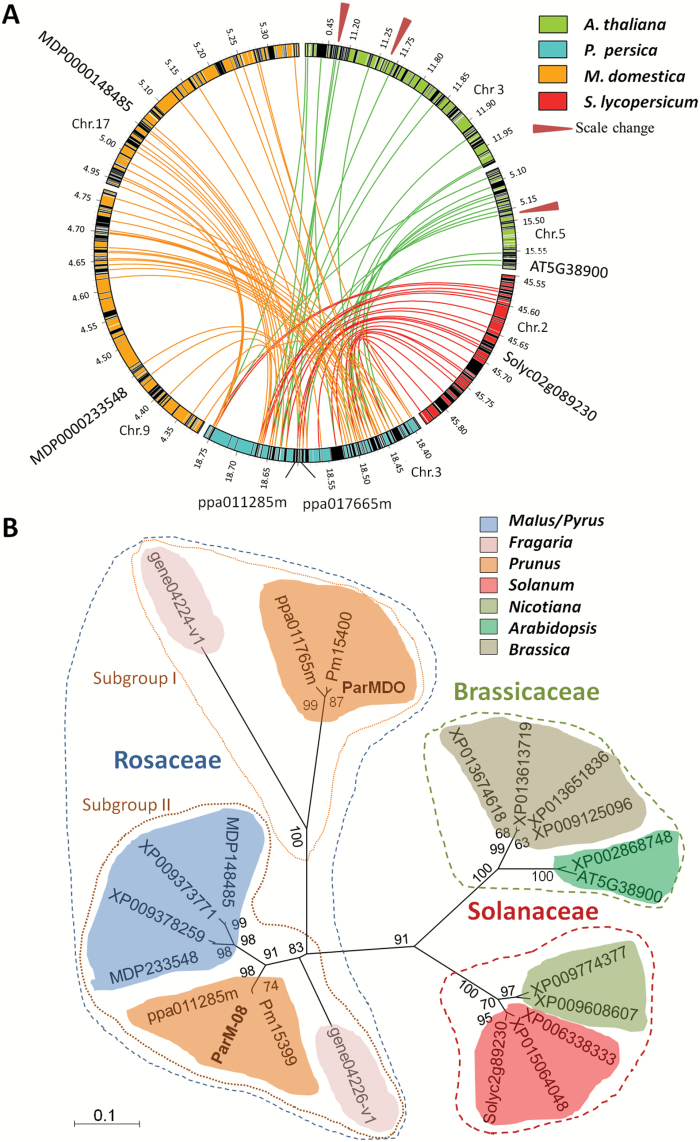
Ortholog analysis of ParMDO. (A) M-locus syntenic blocks between P. persica, M. domestica, S. lycopersicum, and A. thaliana. Black rectangles within circular genome regions represent gene annotation in scale. Red triangles indicate a scale change. Putative ParMDO and ParM-8 orthologs are shown. (B) Clustering analysis of plant DsbA-like proteins. Three main clusters group DsbA-like proteins from Rosaceae (blue dashed line), Solanaceae (red), and Brassicaceae (green). The Rosaceae cluster is subdivided into subgroups I (ParMDO, their Prunus orthologs, and the Fragaria gene04224v1.0 protein) and II (all the rest including ParM-8). Bootstrap values>50% with 1000 replications are shown on the branches. The scale bar indicates the number of amino acid substitutions per site.